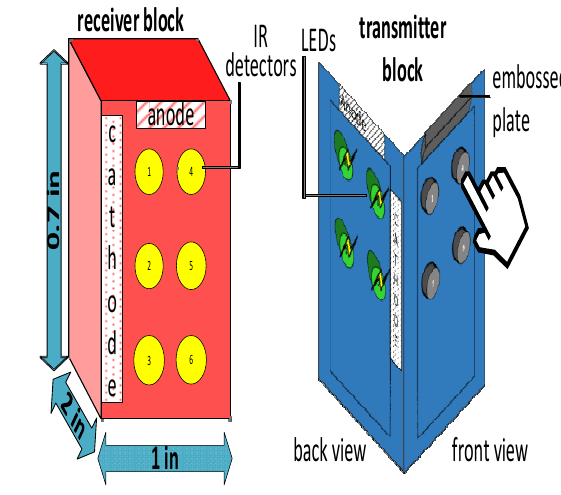
Fig. 1: RX and TX Braille Blocks.